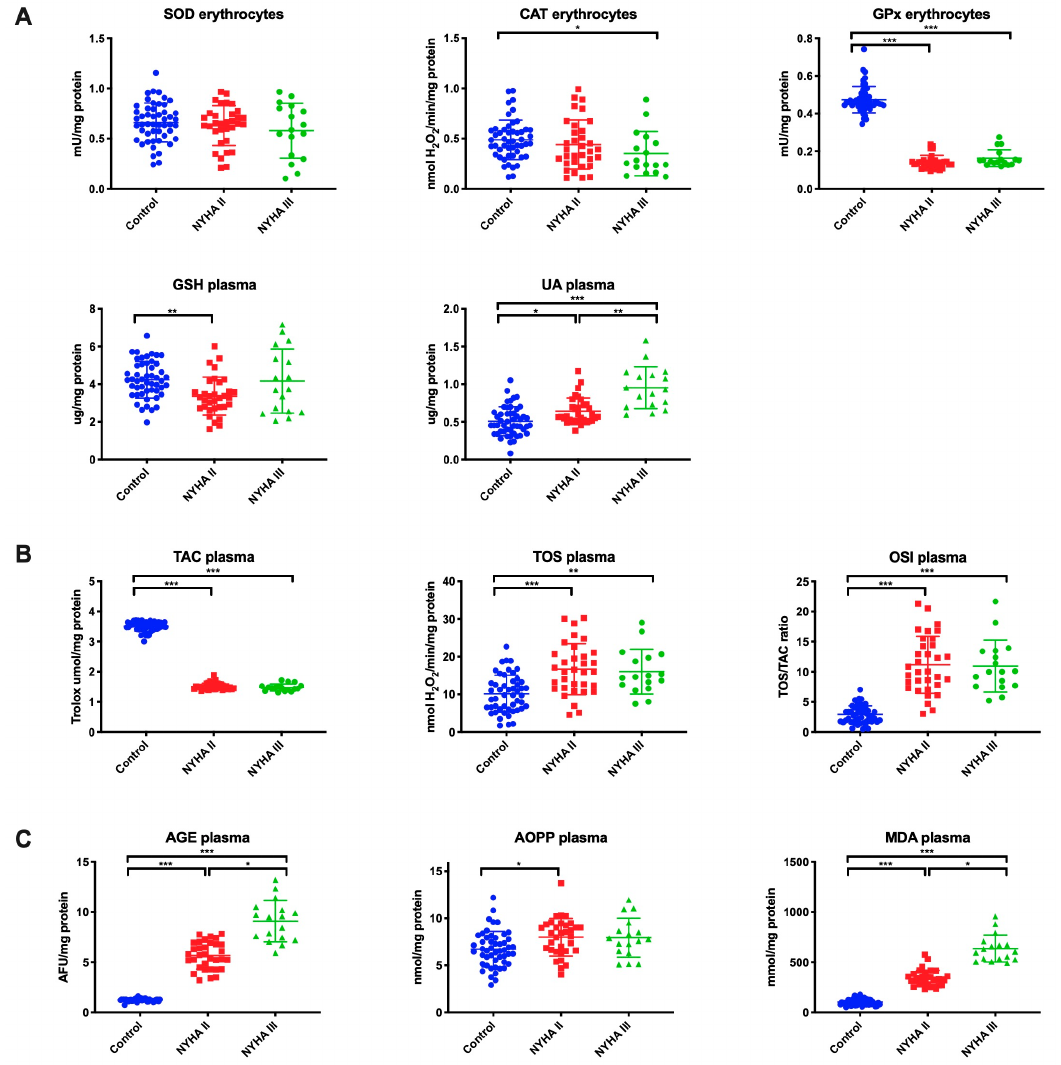
Figure 4. Antioxidant barrier ( A ), redox status ( B ), and oxidative damage to proteins and lipids ( C )